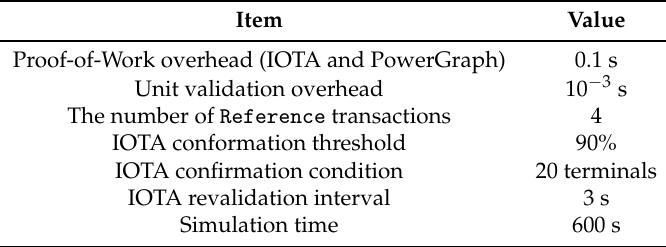
Table 1. Simulation